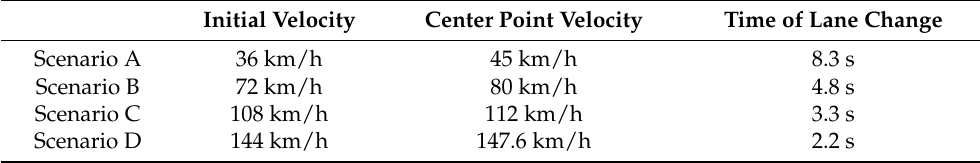
Table 5. Simulation scenarios.